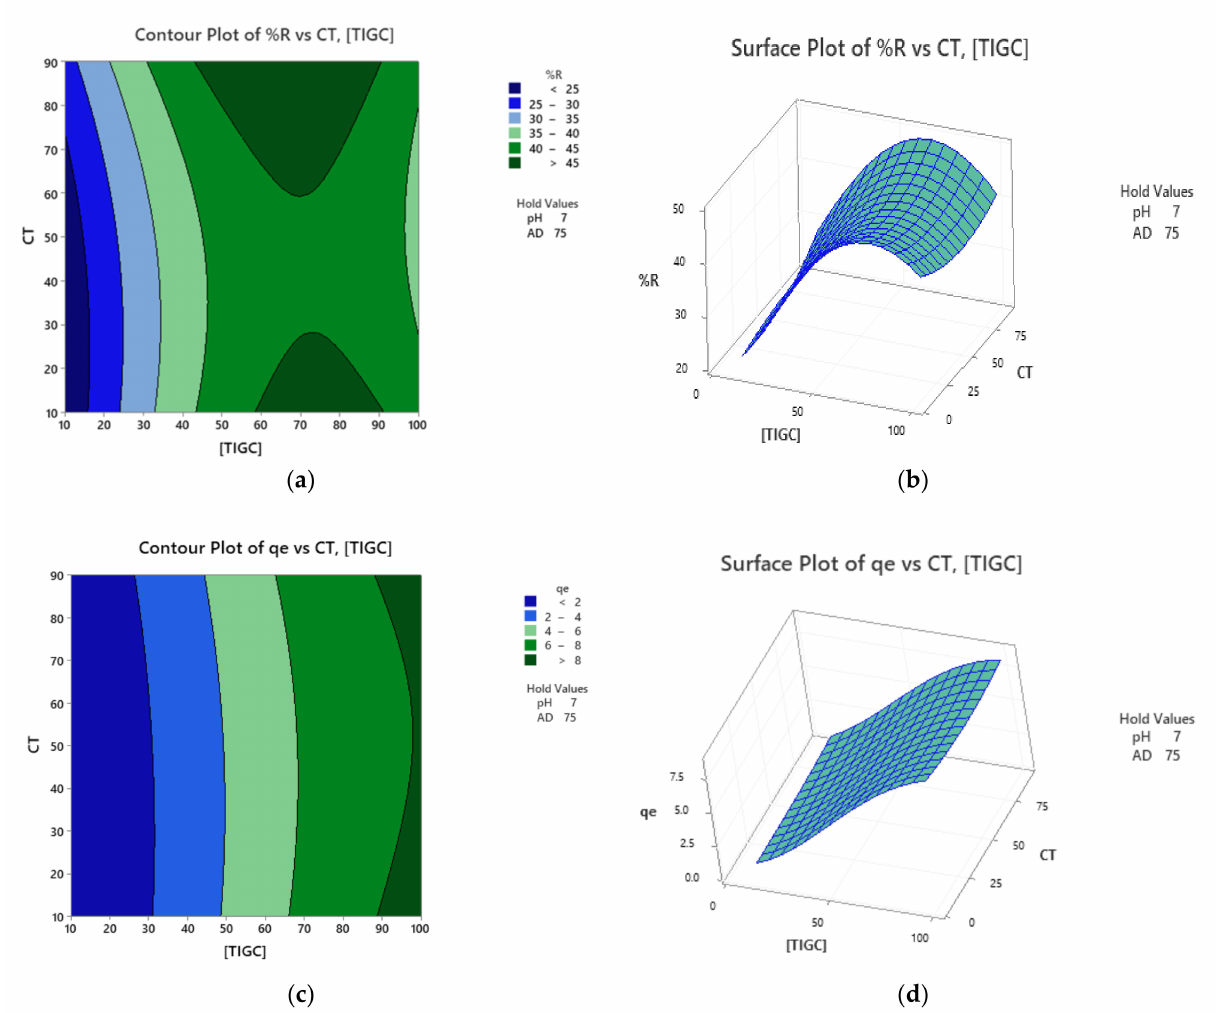
Figure 8. Contour and surface plots using BCDP as adsorbent. ( a , b ) %R is the response measured and ( c , d ) q e is the measured response. Data were obtained following response